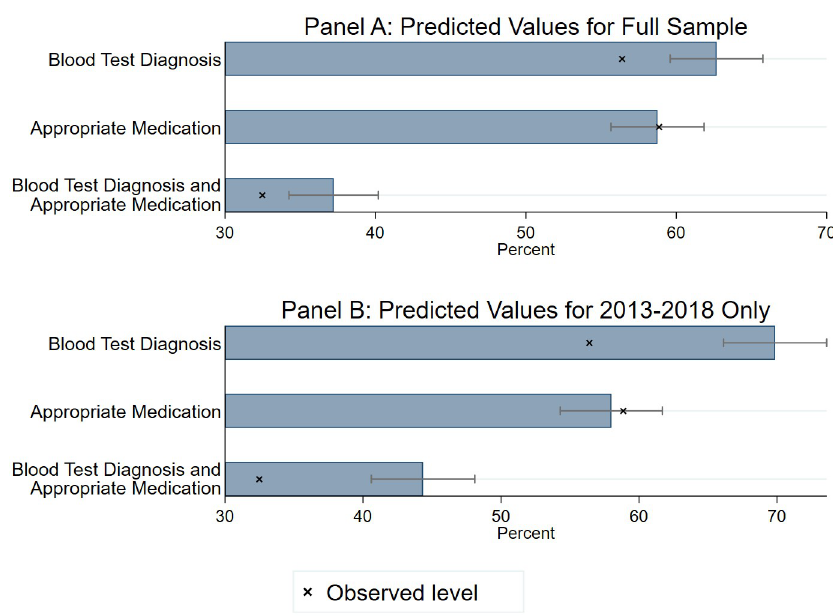
Fig 3. Estimated prevalence of clinical management of children diagnosed with malaria with universal stocking and provider training (N = 6,955 child visits). Estimates are among the sample of children diagnosed with malaria for which covariates included in the model presented in Table 3 are available. “Blood test diagnosis” indicates that the child’s malaria diagnosis was based on either a blood slide microscopy test or a rapid diagnostic test. “Appropriate medication” indicates that the child received an oral ACT, parenteral artemisinin, or injectable quinine. Predicted estimates are based on the model presented in Table 3, under the assumption that all children are seen at a facility that had observed, verified stocking of malaria diagnostic tests and ACTs and that all children are seen by a provider with training in malaria diagnosis and/or treatment, holding all other covariates at their mean value. Data are weighted by SPA-supplied sampling weights to be nationally representative, and 95% confidence intervals are adjusted for clustering within facilities. ACT, Artemisinin Combination Therapy; SPA, Service Provision Assessment.